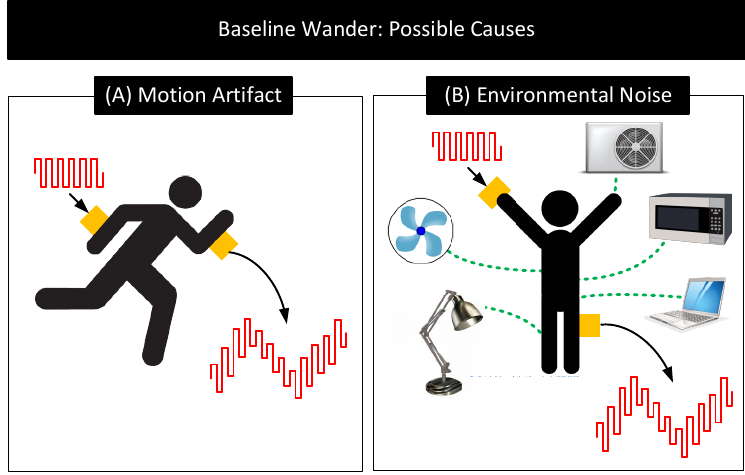
Figure 8. Potential causes for baseline wander. ( A ) Motion Artifact: Distortion of signals due to subject’s movement ( B ) Environmental Noise: Distortion of signals due to the coupling of signals to the body and electrodes from environmental noise sources